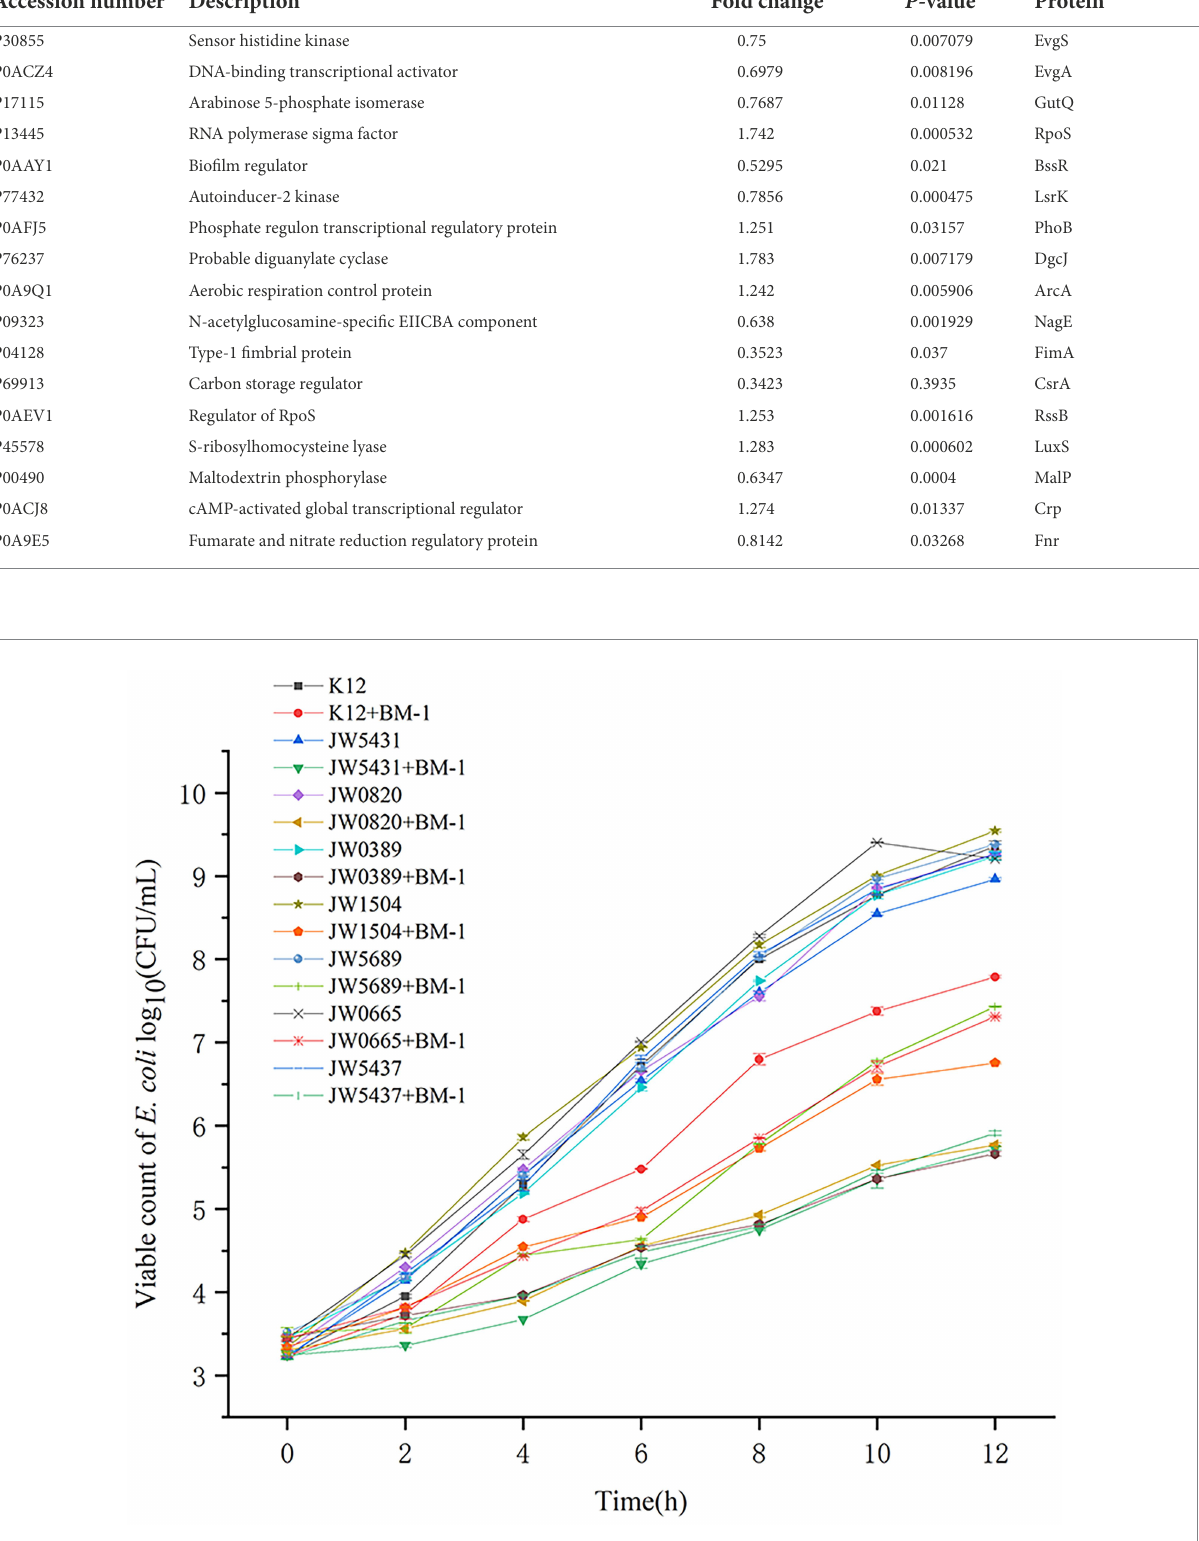
FIGURE 8 Effects of plantaricin BM-1 on the growth of wild-type Escherichia coli K12, mutant E. coli JW5431, JW0820, JW0389, JW1504, JW5689, JW0665, and JW5437 strains ( p <